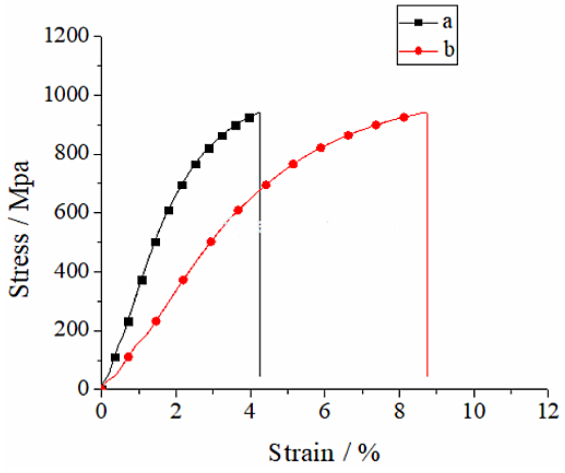
Figure 11. Stress–strain curves of CoCrMo alloy: ( a ) SLM; ( b ) Cast.